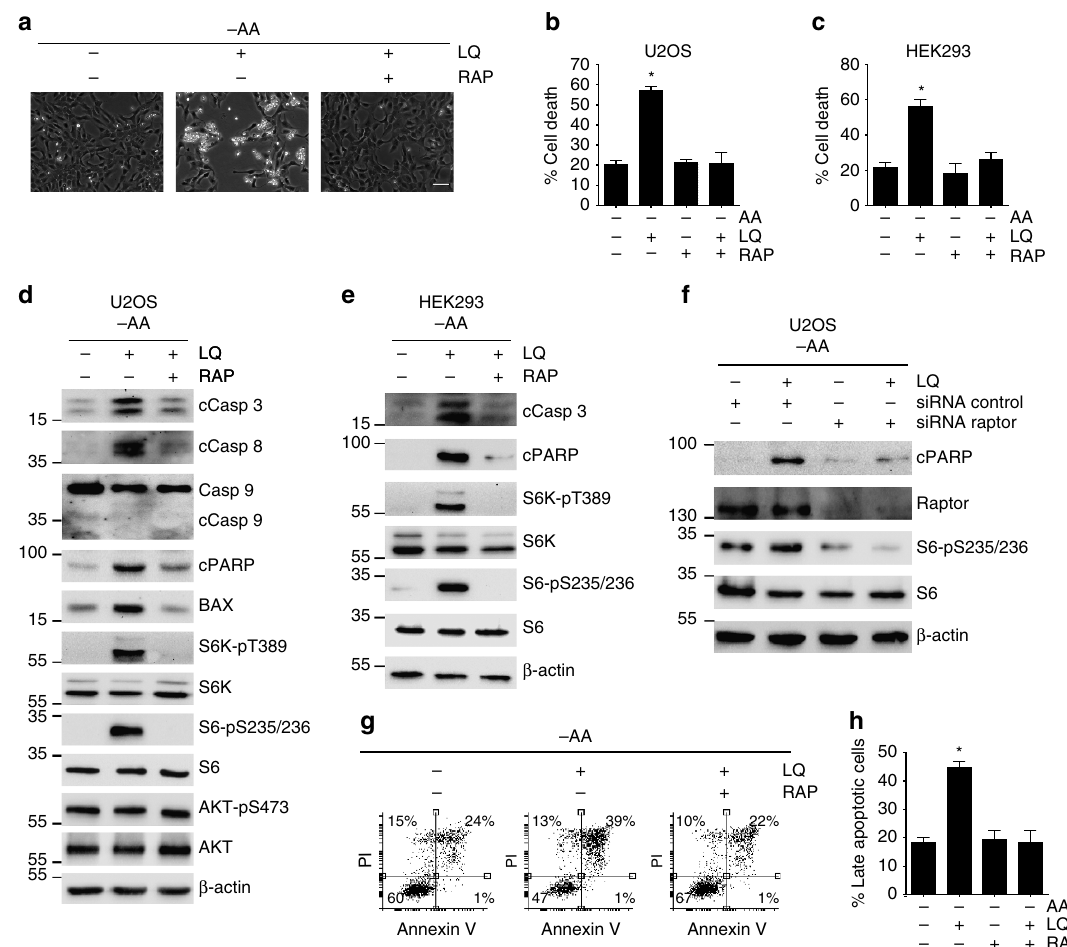
Figure 3 | mTORC1 inhibition prevented the glutaminolysis induced apoptosis. ( a ) Representative microscopy image of U2OS cells upon LQ treatment either in the presence or the absence of rapamycin after 72h. The scale bar represents 100 m m. ( b , c ) Percentage of cell death as estimated using trypan blue exclusion assay is U2OS cells ( b ) or HEK293 cells ( c ) upon LQ treatment either in the presence or the absence of rapamycin for 72h (U2OS) or 144h (HEK293). ( d , e ) Western blot analysis of apoptotic markers and mTORC1 downstream targets upon rapamycin (RAP) addition in LQ-treated U2OS cells ( d ) and HEK293 cells ( e ). ( f ) Western blot analysis of apoptotic markers and mTORC1 downstream targets upon the silencing of Raptor using siRNA (thus inhibiting mTORC1 activity) in LQ-treated U2OS cells. ( g ) Flow cytometry analysis of annexin V/PI staining of U2OS cells treated with LQ and rapamycin as indicated. ( h ) Quantification of late apoptosis (annexin V/PI-positive cells) for the U2OS cells treated as in g , as indicated. Graphs show